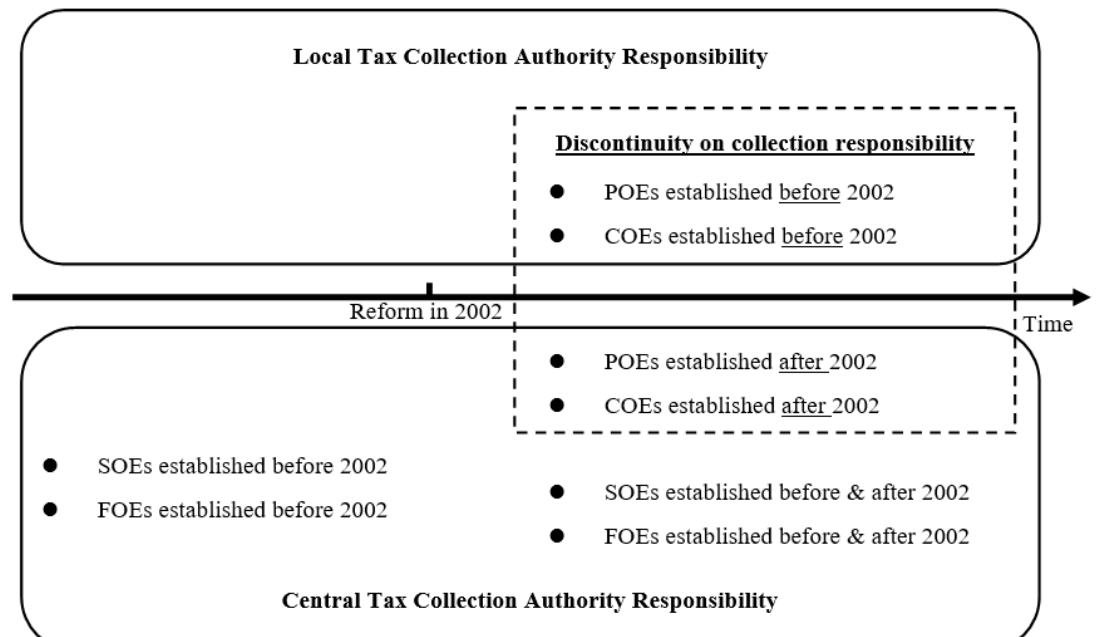
Figure 1. Changes in tax collection responsibility and the regression discontinuity design. POEs (private-owned enterprises), COEs (collective-owned enterprises), SOEs (state-owned enterprises), FOEs (foreign-owned enterprises).